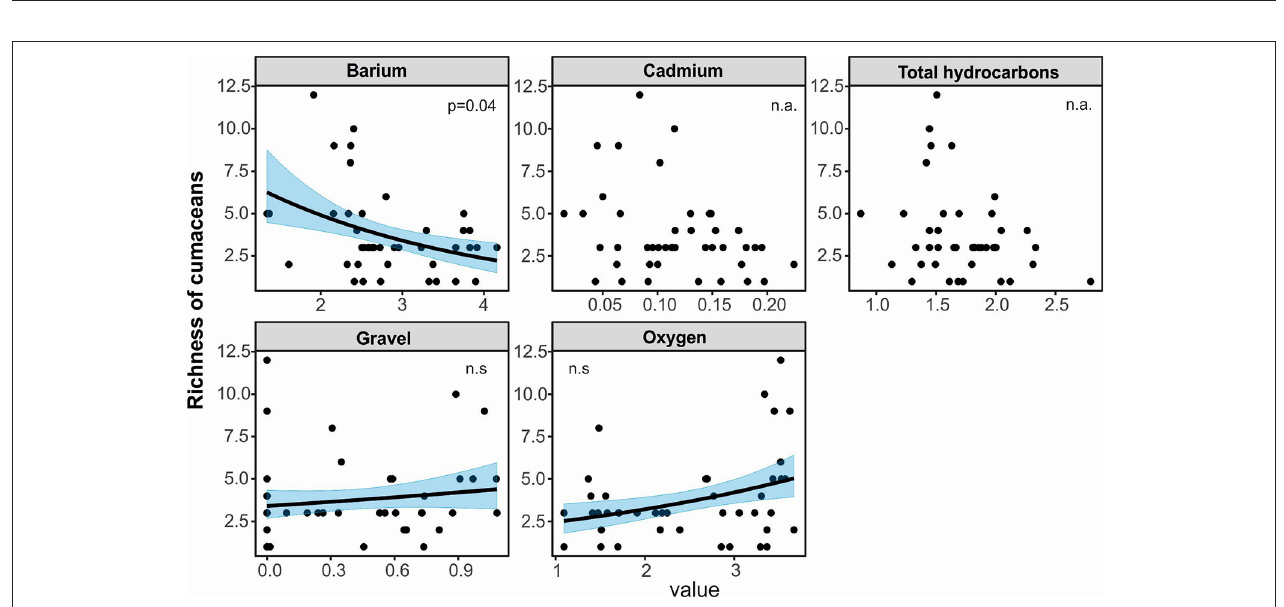
FIGURE 9 | Visualization of generalized linear model testing for effects of environmental factors on species richness of cumaceans. Phrase “n.a.” means that environmental factor was not included in a set of the most parsimonious models. Phrase “n.s.” means its explanatory power was not significant despite the fact that means environmental factor was included in a set of the most parsimonious